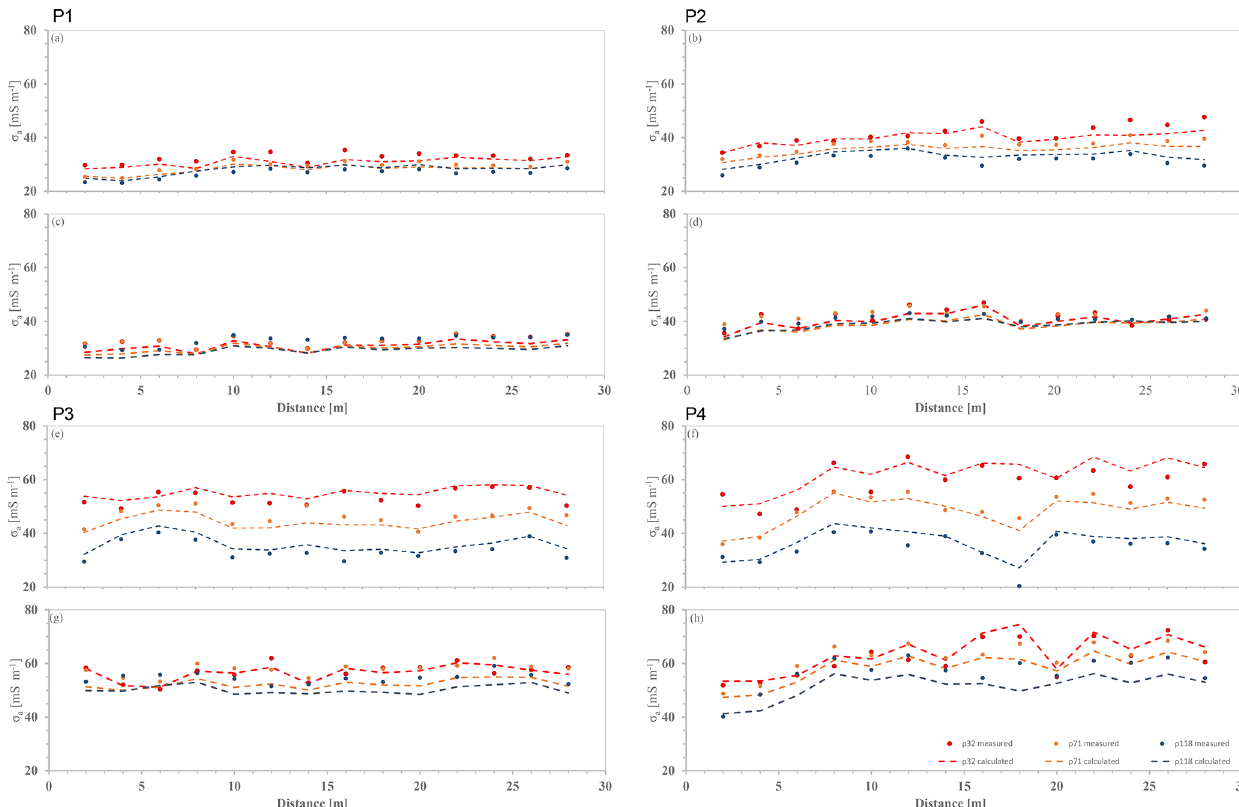
Figure 12. σ a distribution of the middle transect in four experimental plots, P1, P2, P3 and P4, for 23 November. Panels (a) , (b) , (e) and (f) show the VCP configuration, and panels (c) , (d) , (g) and (h) show the HCP